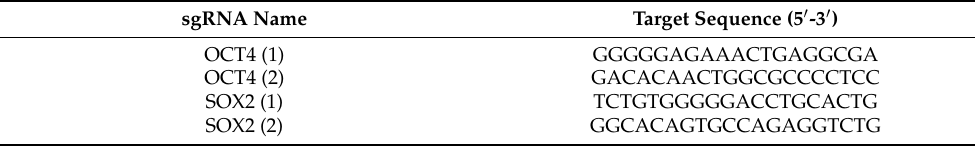
Table 1. sgRNA target sequence on human OCT4 and SOX2